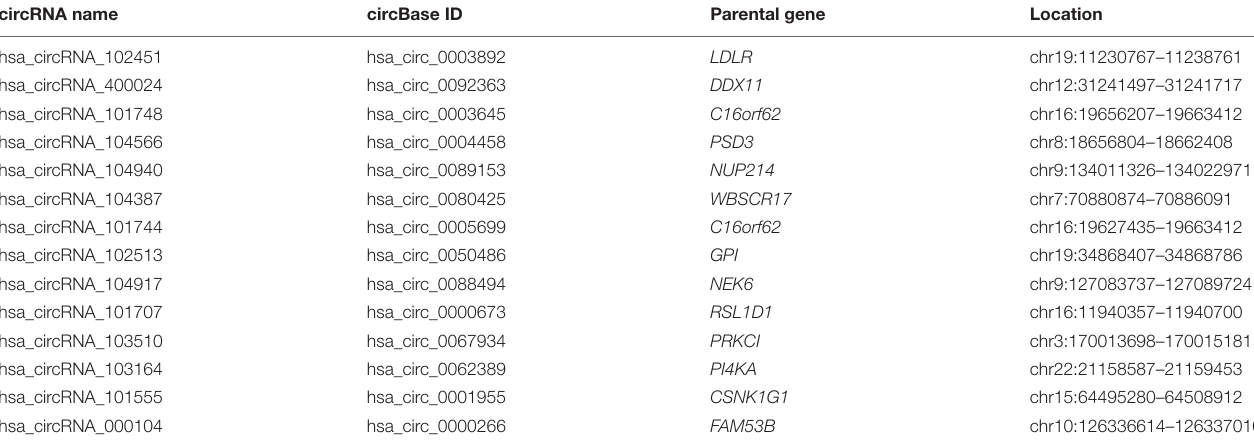
TABLE 3 | Fourteen candidate circRNAs associated with progression of papillary thyroid carcinoma (PTC) and their corresponding